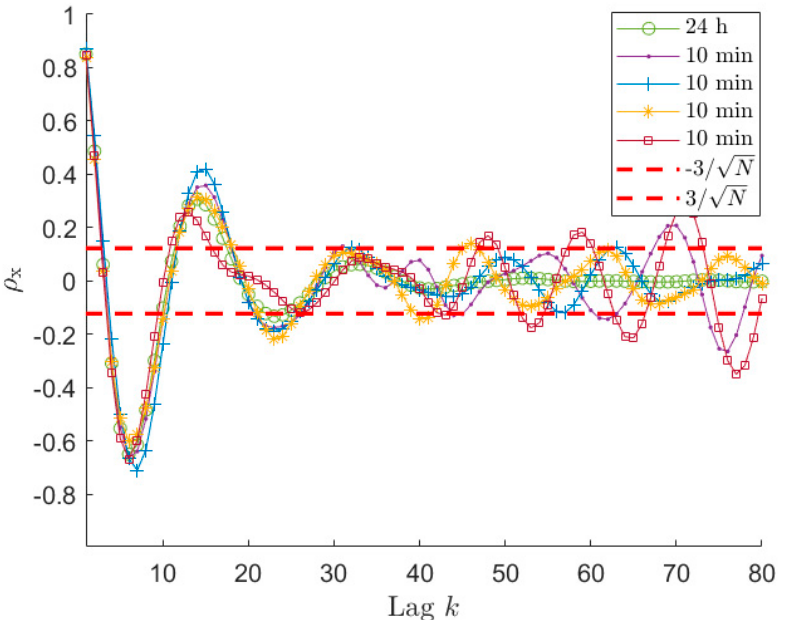
Figure 7. Normalised auto − covariance ρ x curves for a signal 24 h long and four signals 10 min long. The ±3/√𝑁 range is related to the four 10 min long signals. These four signals have φ(cid:3549) be- tween 17 and 25, depending on the time series.